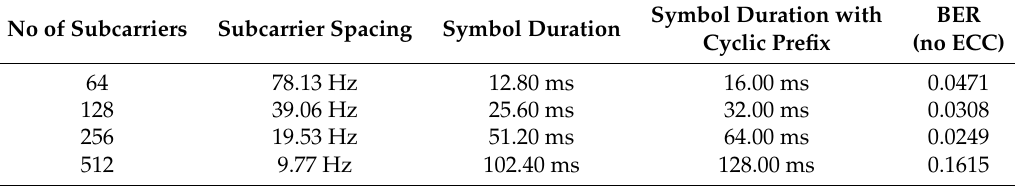
Table 2. Configurations of OFDM signal parameters and BER achieved during the inland-water experiment. No of Subcarriers Subcarrier Spacing Symbol Duration